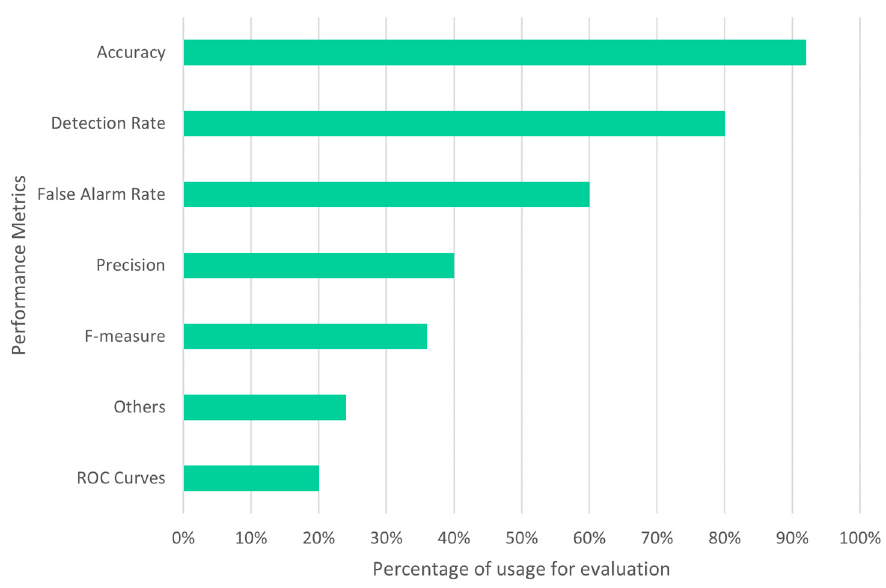
Figure 6. Metrics used (Section 6).